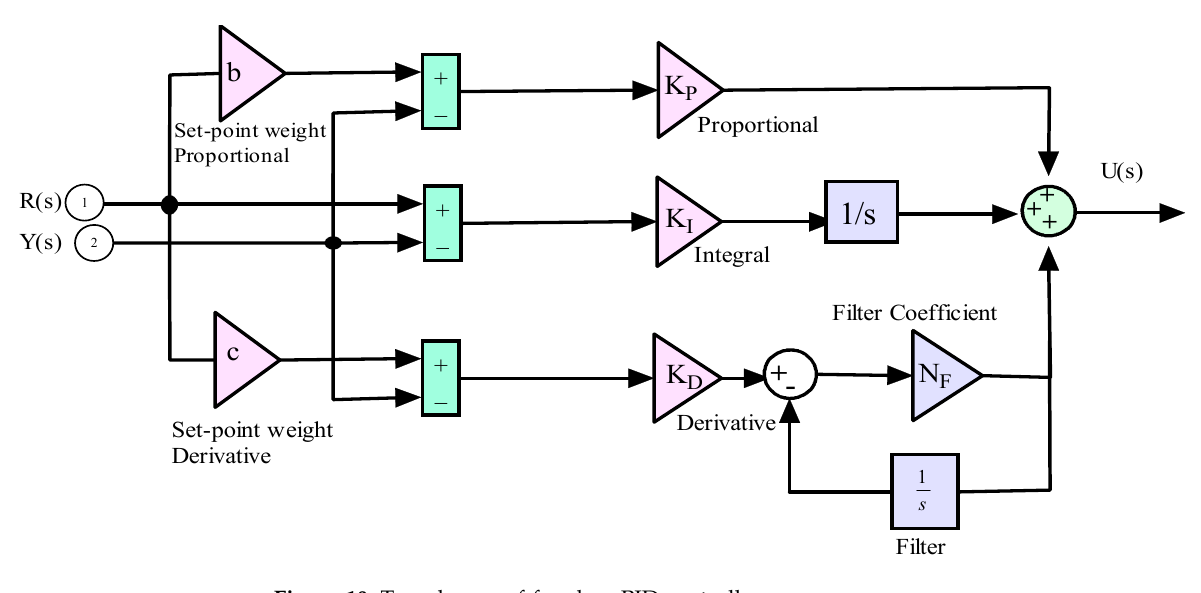
Figure 10. Two-degree-of-freedom PID controller.